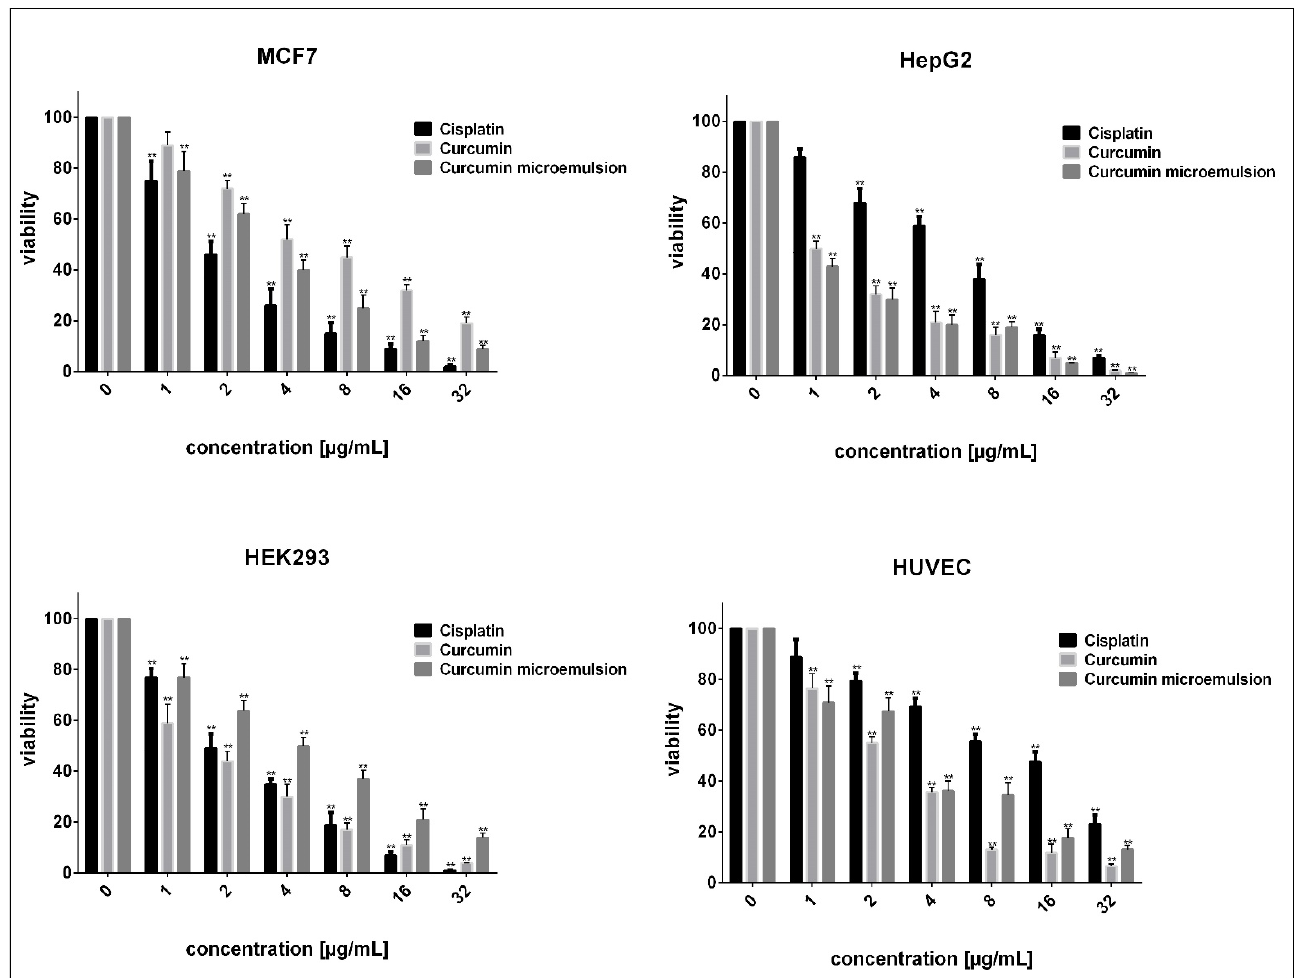
Figure 4. Cytotoxic effects of free curcumin, curcumin microemulsion, and cisplatin (as positive control) on malignant (HepG2 and MCF7) and non-malignant (HUVEC and HEK293) cell lines using MTT assay. The results represent the mean ± SD of three independent experiments. (** p < 0.05 compared with untreated cells).